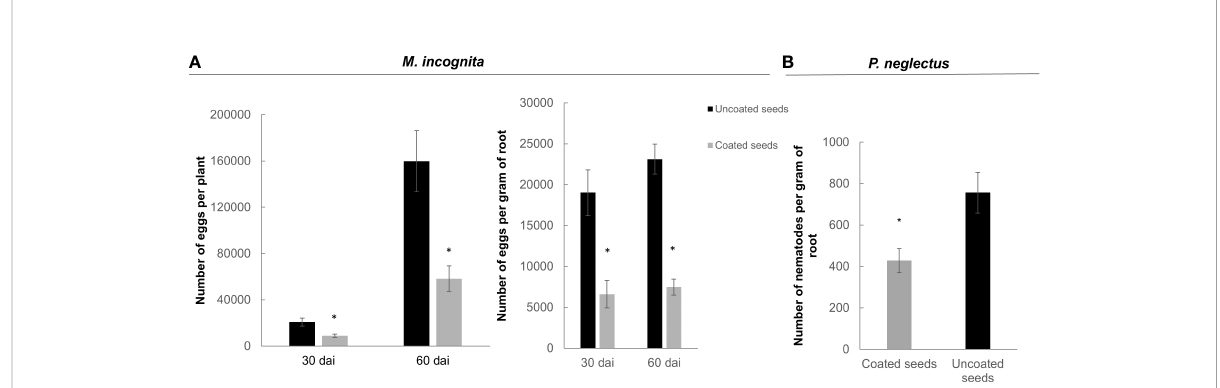
FIGURE 8 Nematode reproduction ( Meloidogyne spp. and Pratylenchus spp.) in soybean plants from bacteria coated seeds. (A) Number of nematode eggs per plant (left) and nematode eggs/gram (right) of root of Meloidogyne spp. measured at 30 (one infection cycle) and 60 days (two infections cycles) after soybean inoculation with 5000 eggs of M. incognita. (B) Number of Pratylenchus spp. specimens measured 40 days after soybean sowing in nematode natural infested soil. The dual-strain combination of B paralicheniformis FMCH001 and B subtilis FMCH002 was applied by seed coating. Bars are mean ± standard error (n=9). Asterisk represents signi fi cant difference to non-treated control seeds (t-test; p < 0.05).